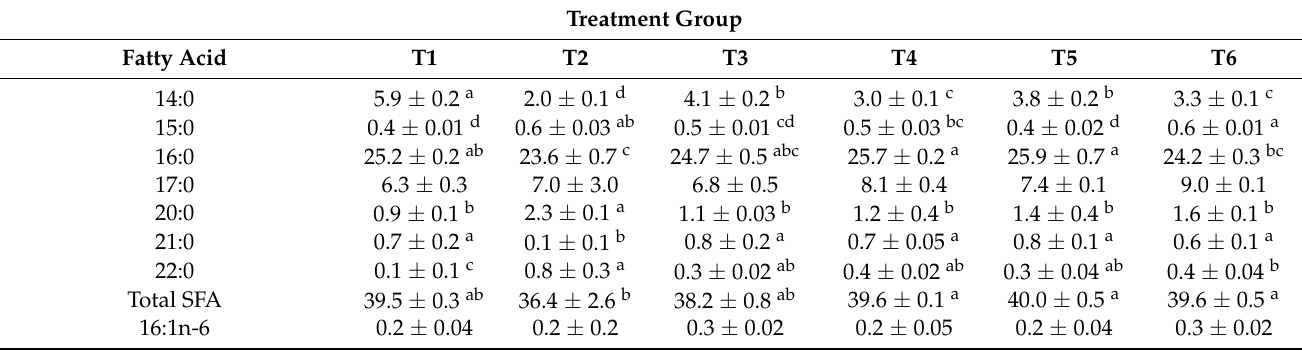
Table 4. Proportions of fatty acids of post-set sunray venus clams ( Macrocallista nimbosa ) fed different diet combinations of live microalgae. Treatment Group